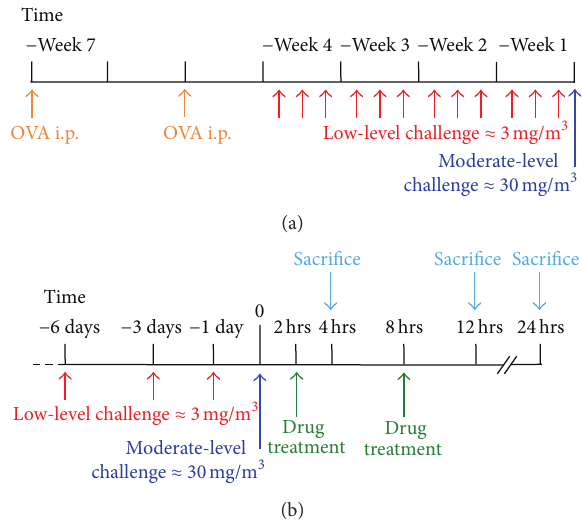
Figure 1: Timeline showing (a) sensitisation/challenge in the model of an acute exacerbation of chronic asthma and (b) timing of drug administration and sample collection following induction of an acute